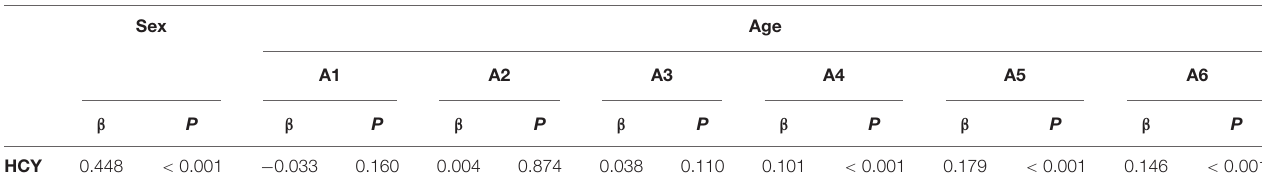
TABLE 2 | Results of multiple linear